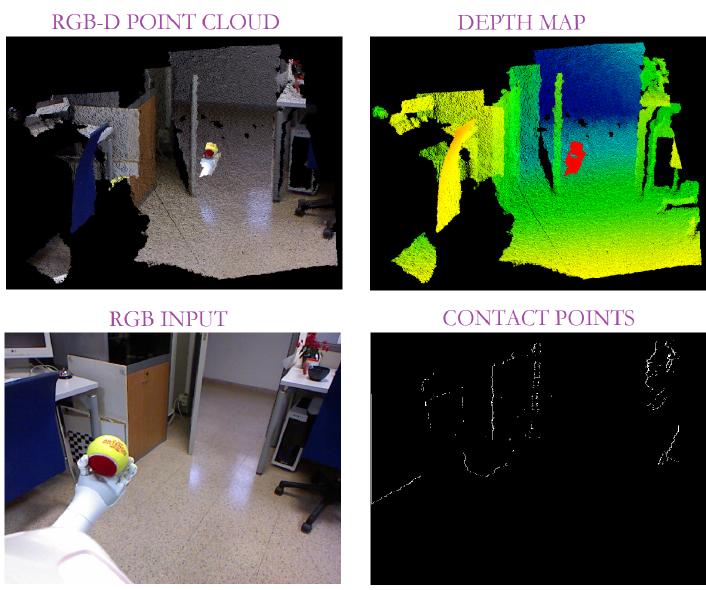
Figure 6. Contact points detected by the depth-based map.